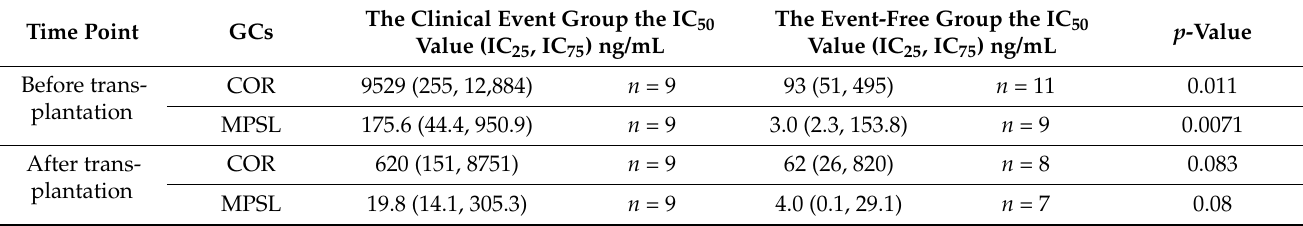
Table 3. Comparison of the IC 50 values between the clinical event group and the event-free group regarding the incidence of acute graft rejection